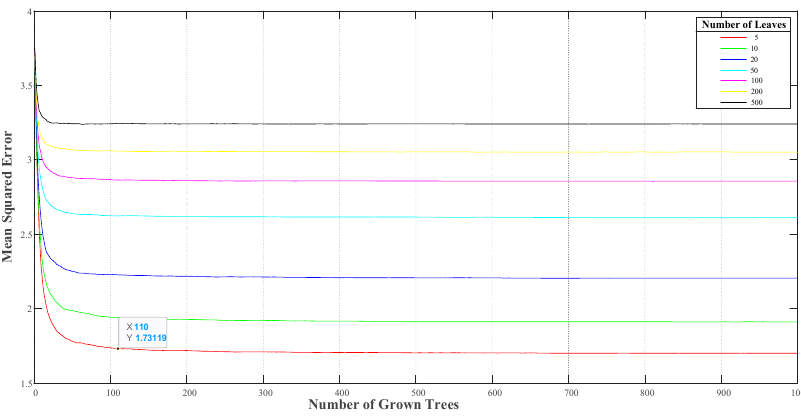
Figure 11. Parameter selection of random forest (cleaning rate 46.44%).